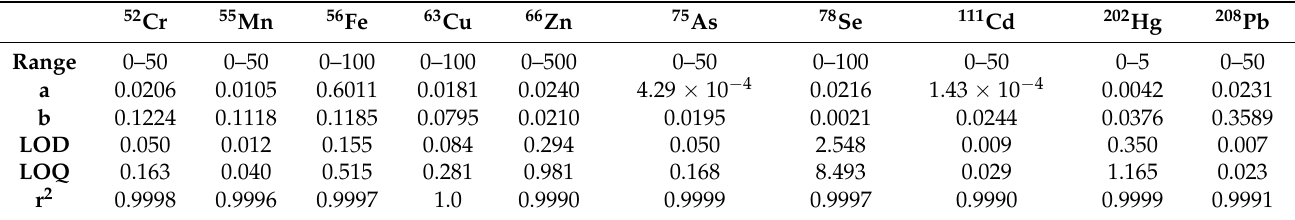
Table 1. Concentration range, calibration (a: intercept, b: slope, r 2 : determination coefficient), limits of detection (LOD), and quantification (LOQ), in µ g L − 1 , for metals and metalloids analyzed in surface seawaters.